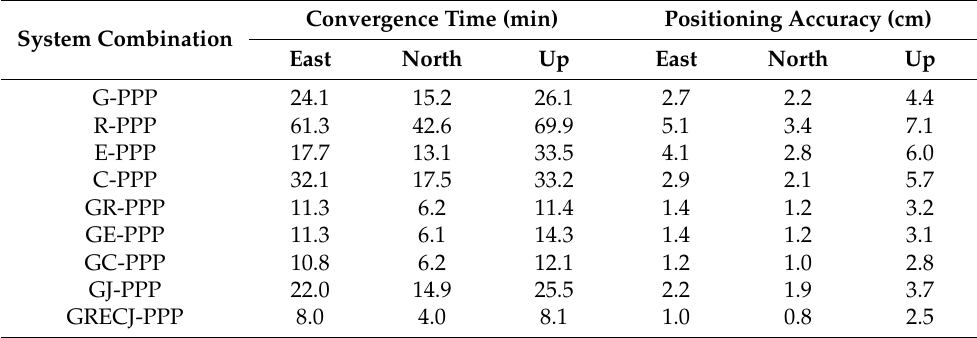
Table 14. Kinematic positioning accuracy and convergence time of post-processed PPP (long-term performance of PPP based on daily observations) with GFZ products for different system combina- tions using the datasets from 29 stations spanning a week.